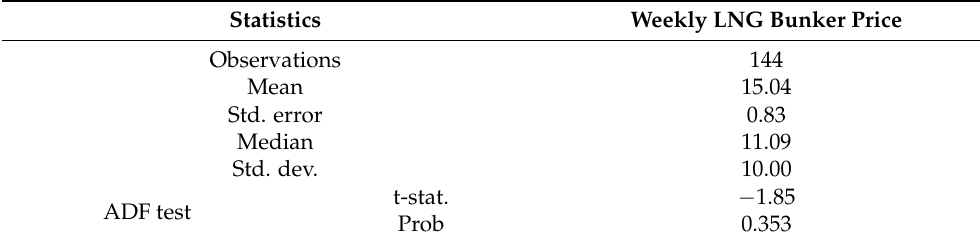
Table 2. Descriptive statistics of liquefied natural gas bunker